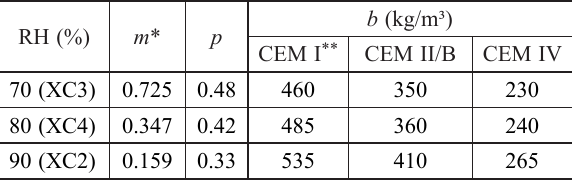
Table 2. Values of m *, p and b factor (LNEC E465 2009)